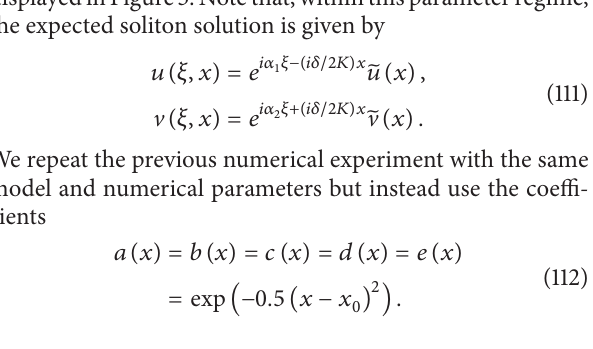
) , with 𝑝 = 1, 4, 1/16 0